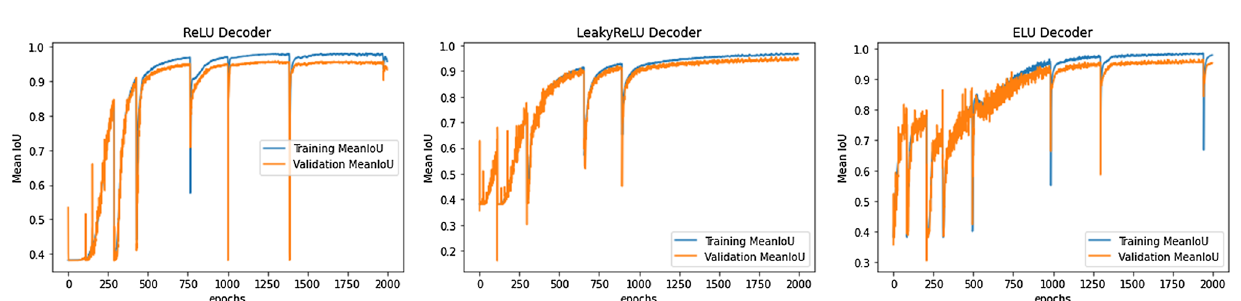
Fig. 5 Comparative activation performance. This figure presents the training and validation paths under different activation where TP refers to true positives, FN refers to false negatives and FP refers to false positives. Sparse categorical cross entropy loss is the same equation used to train the model (see Eq. 2).